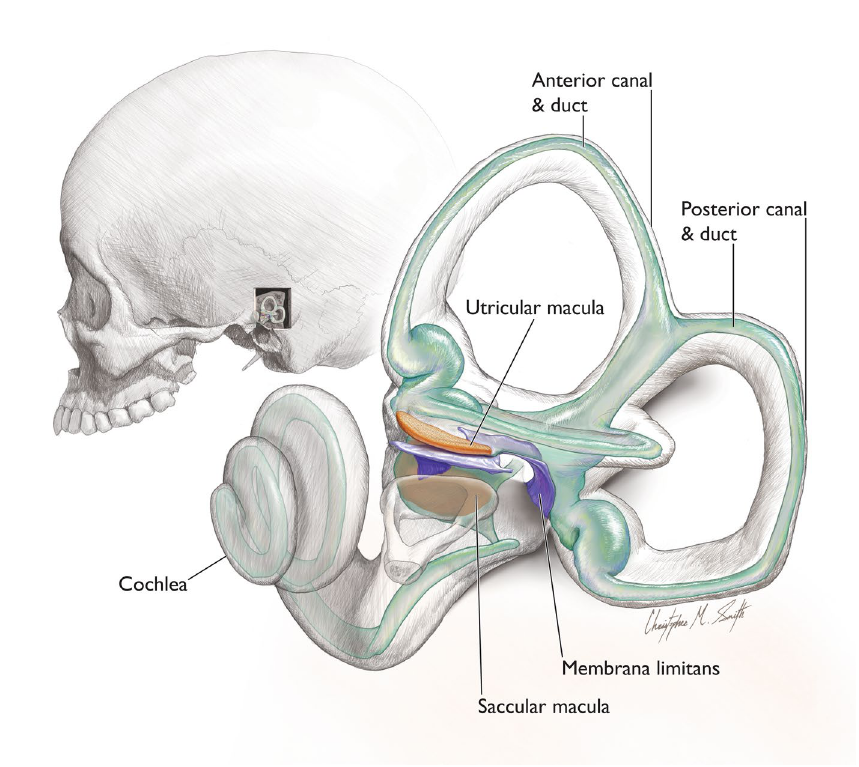
Figure 1. Inner ear anatomy. ( A ) Left lateral view of inner ear within the human cranium; ( B ) left bony labyrinth enlarged. Membranous labyrinth shown in green; maculae shown in orange. The membrana limitans (blue) is a membranous “hammock” that serves to support the utricle and its neural substrate by attaching to the walls of the bony vestibule. Illustration by CMS. Modified from 9